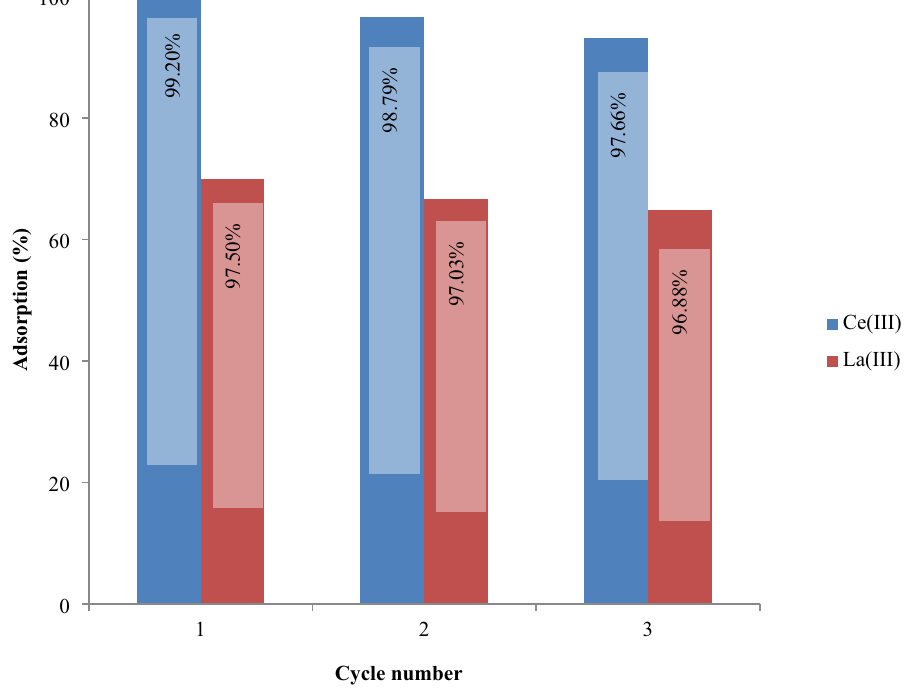
Figure 11. Adsorption–Desorption efficiency of SIR in 3 consecutive cycles using HCL 0.1 mol L −1